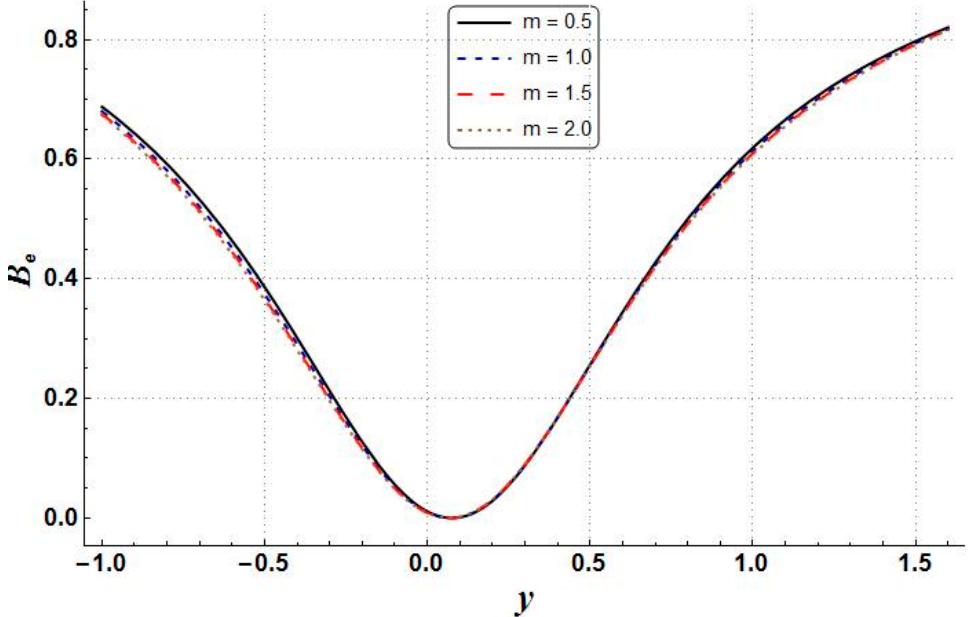
, x = 0, Gr = 2, α = π , 4 4 M , where